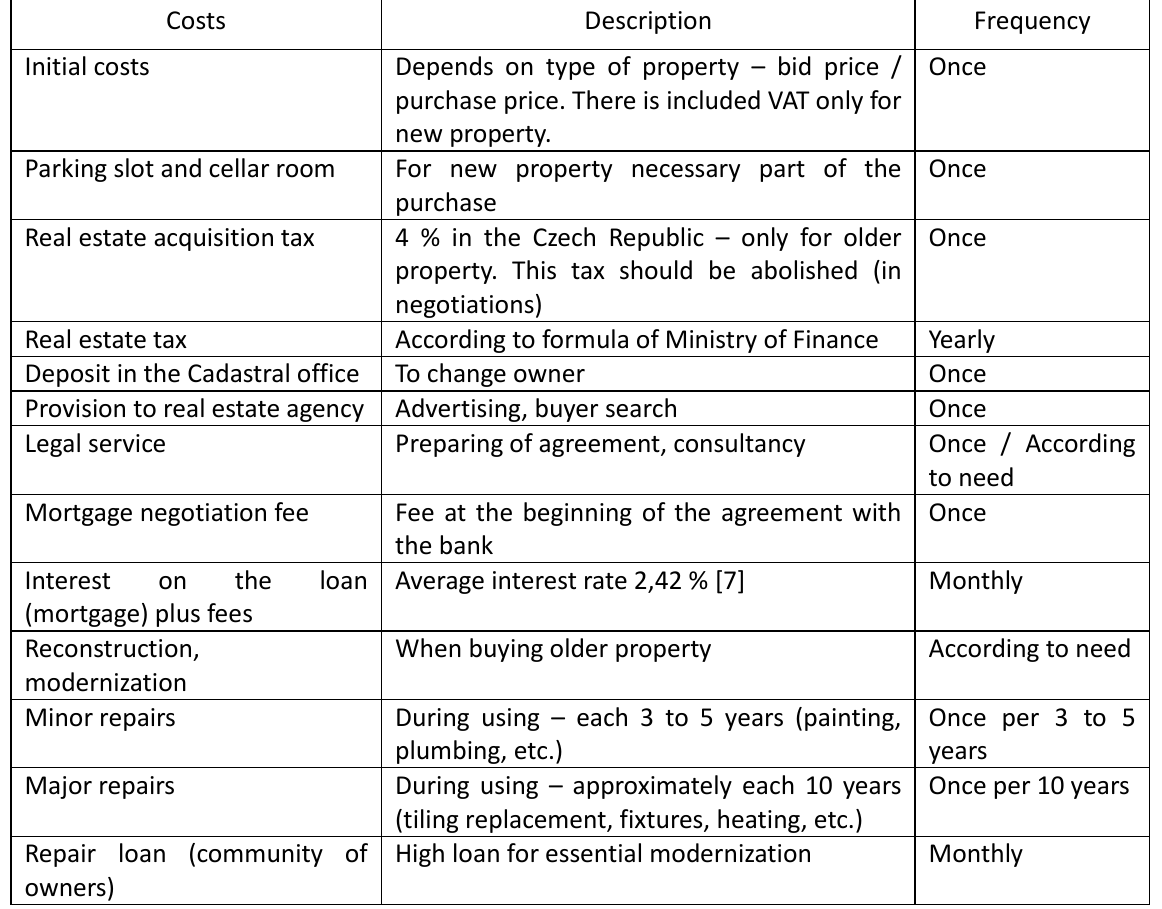
Table 2: Typology of operated and related costs. (Source: Authors